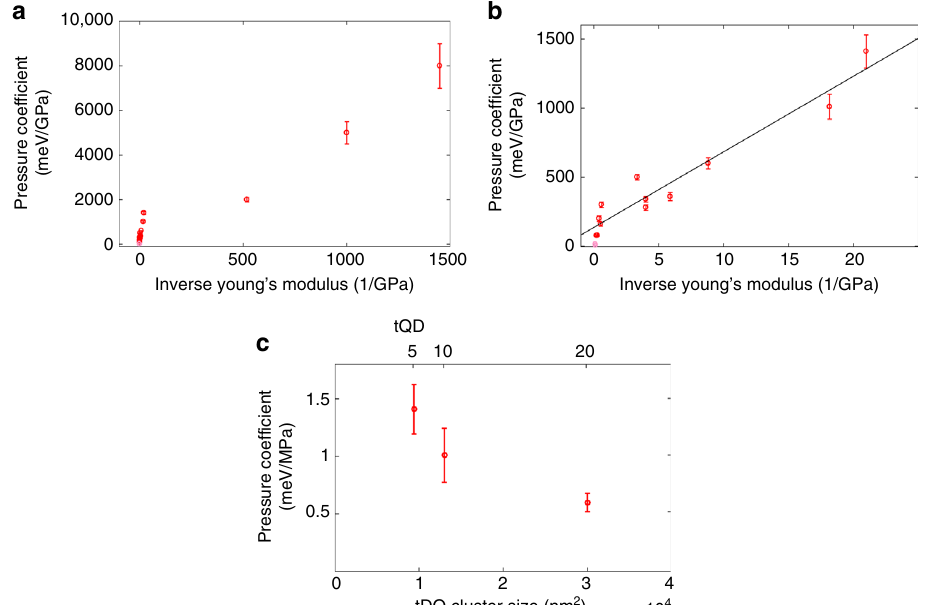
Fig. 4 High dynamic range of tQD pressure coef fi cients. a Monotonic scaling of the tQD pressure coef fi cient over three orders of magnitude with the polymer inverse Young ’ s modulus. b Plot of the initial region shown in a (inverse Young ’ s modulus <200/GPa). c Plot of pressure coef fi cient as a function of tQD cluster size for three concentrations of tQDs in SEBS. Error bars represent standard error of the mean (SEM) and each mean is the average of 10 – 15